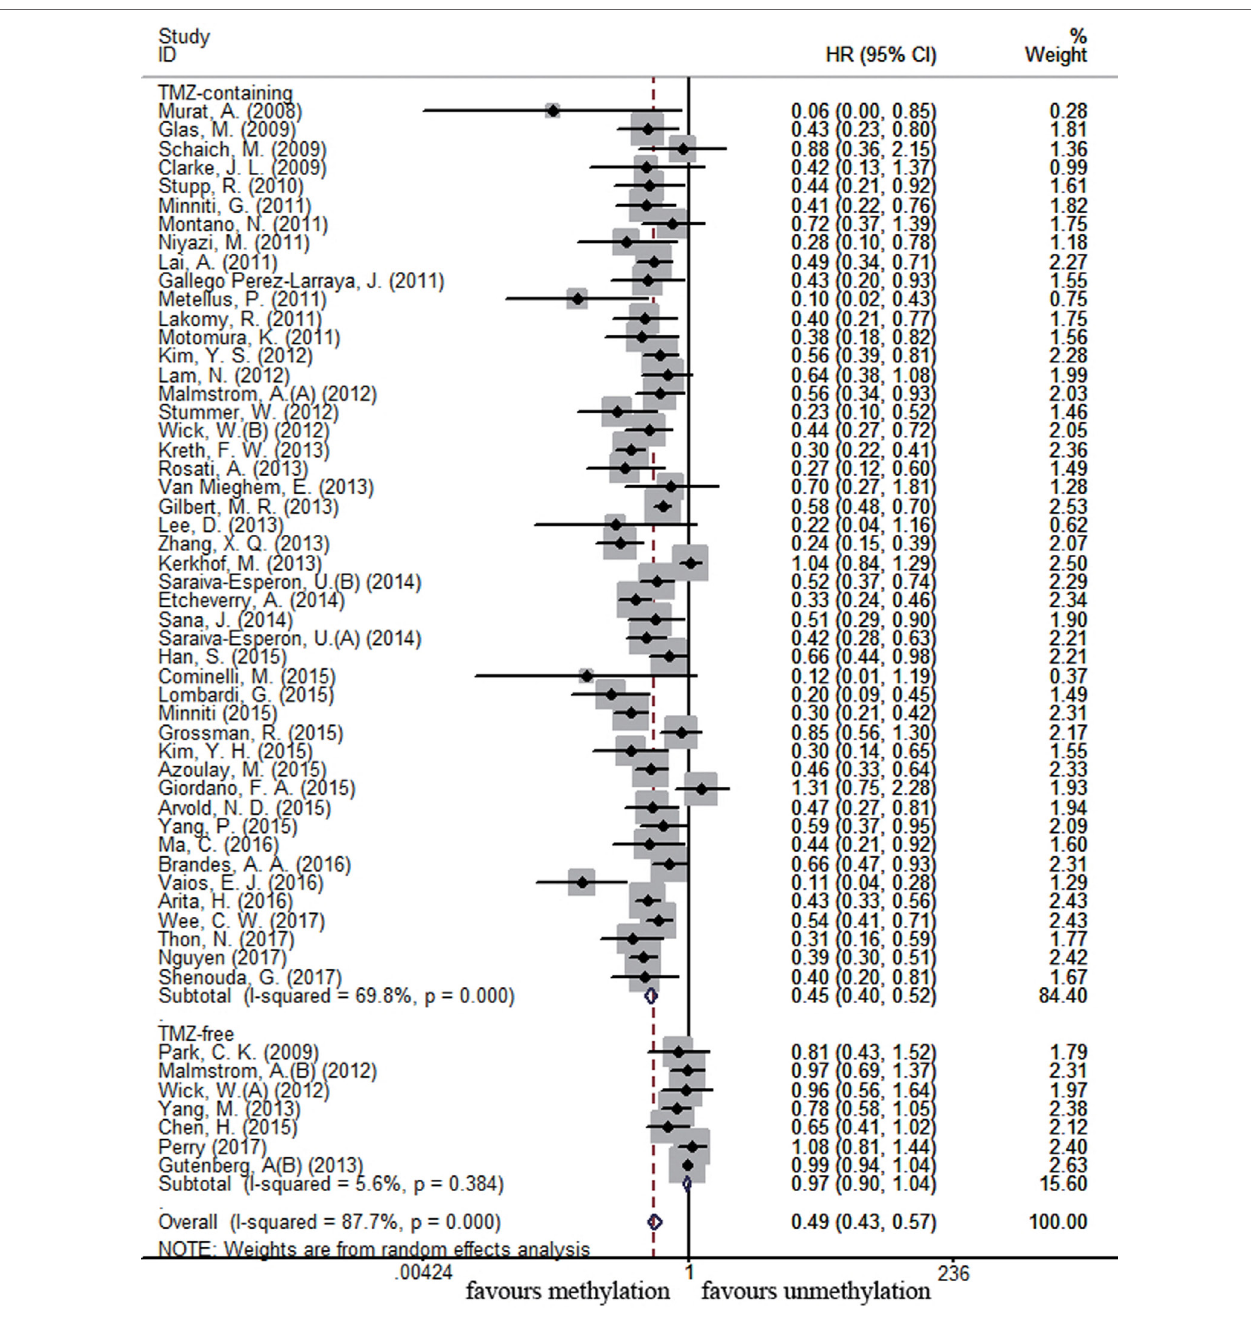
FiGURe 4 | Calculated HRs and 95% CIs for the relationship between methylation and OS benefit from TMZ-containing or TMZ-free therapy in newly diagnosed GBM patients (methylated vs. unmethylated patients).